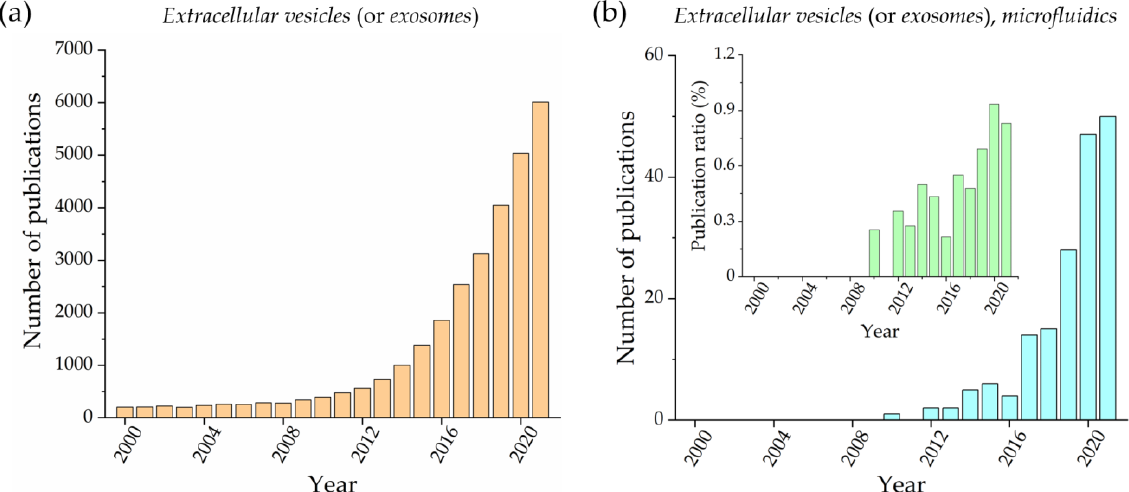
Figure 1. Number of publications per year that contain the keywords: extracellular vesicles (or exosomes ) ( a ) and extracellular vesicles (or exosomes ) and microfluidics ( b ). An inset with the ratio between these two numbers is also reported. (Source: Web of Science database, excluding review, meeting abstract, and retracted papers).